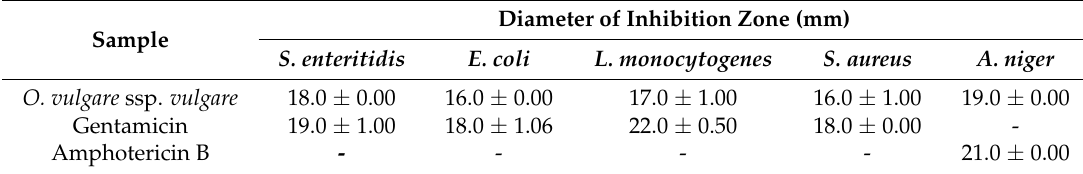
Table 3. Antimicrobial activity of O. vulgare ssp. vulgare extract.